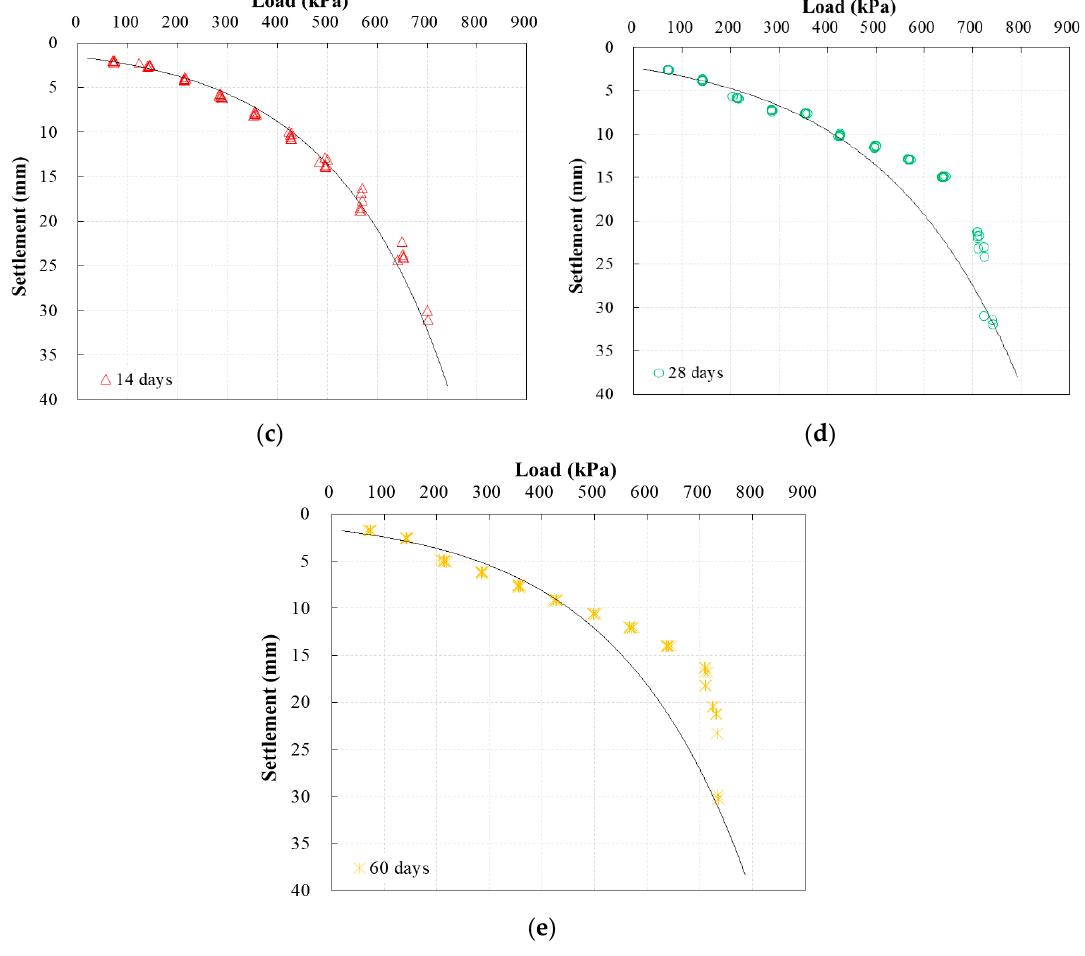
Figure 14. Plate bearing test results for CLSM over time, with elapsed time of ( a ) 1 day; (b) 7 days; ( c ) 14 days; ( d ) 28 days; ( e ) 60 days.